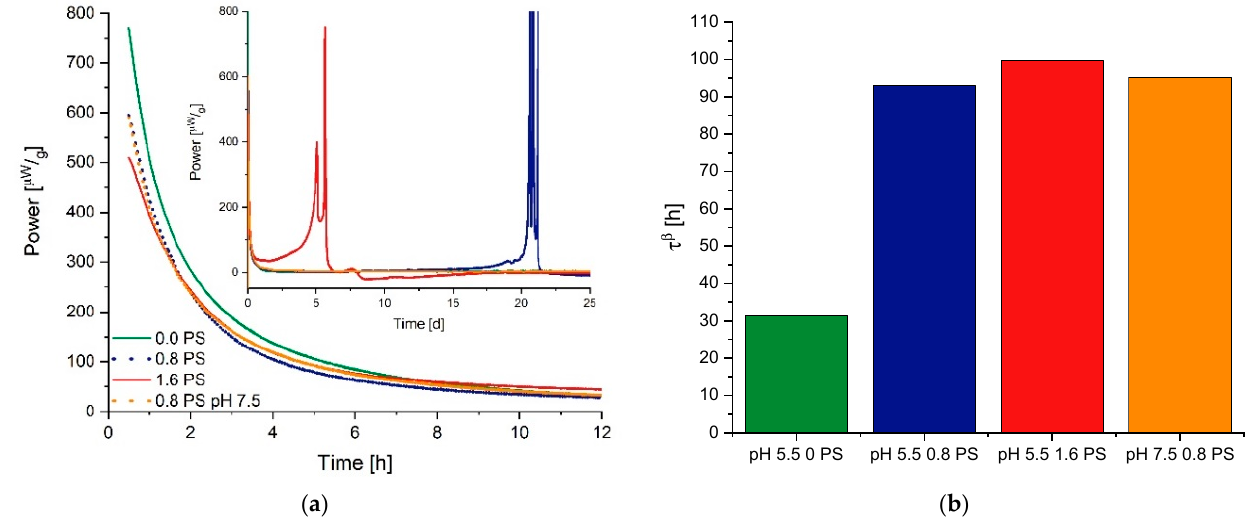
Figure 11. ( a ) Relaxation behavior of sucrose formulations containing 2 mg/mL IgG 1 antibody and a different concentration of polysorbate 20 from a range 0.0–1.6 mg/mL. Except one formulation with a pH of 7.5, all other samples had a pH of 5.5. The measurement was performed by isothermal microcalorimetry with a measurement temperature of 40 °C. The small picture shows the complete measurement, which was performed over 25 days. The different crystallization peaks within a formulation most likely result from sample pooling to reach the needed amount of sample for the measurement. ( b ) Calculated values of τ β MSE